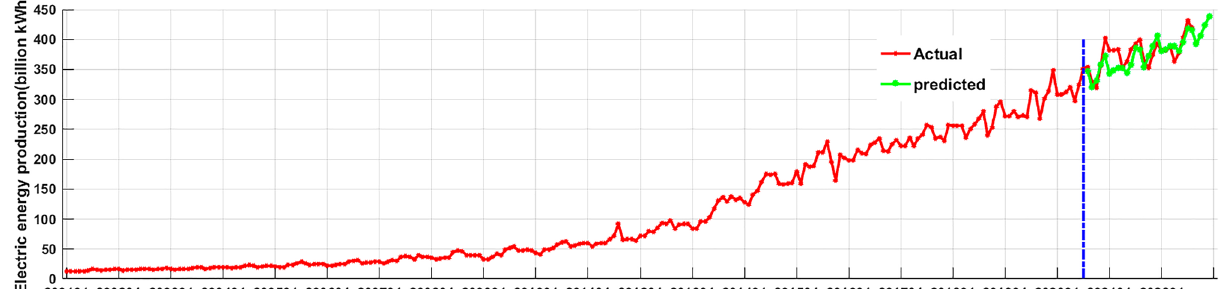
Figure 10. The curves of actual values and predicted values of electric energy production of Xinjiang (since the x-axis length is limited, only the January location of each year is marked in the